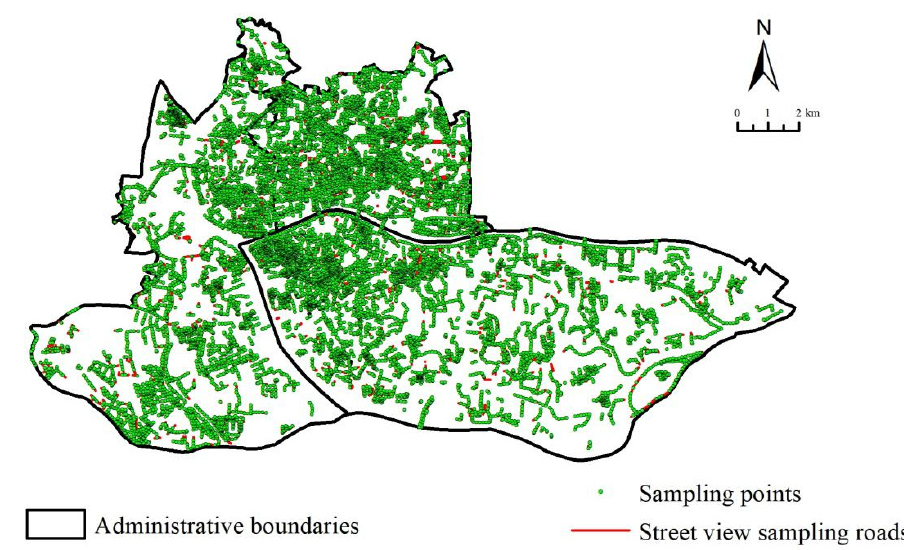
Figure 3. Spatial distribution of Sampling Points of Streetscape